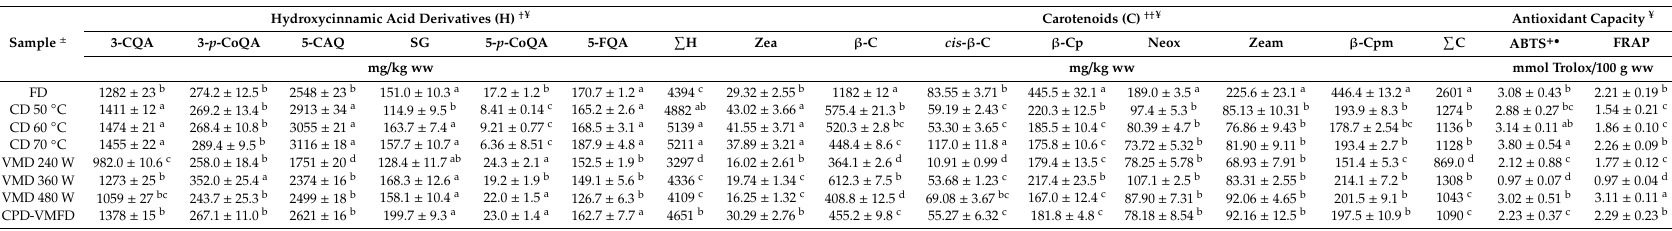
Table 3. E ff ect on hydroxycinnamic acid derivatives, carotenoids compounds and antioxidant capacity ABTS + • and FRAP radical of dried loquat (ww). Sample